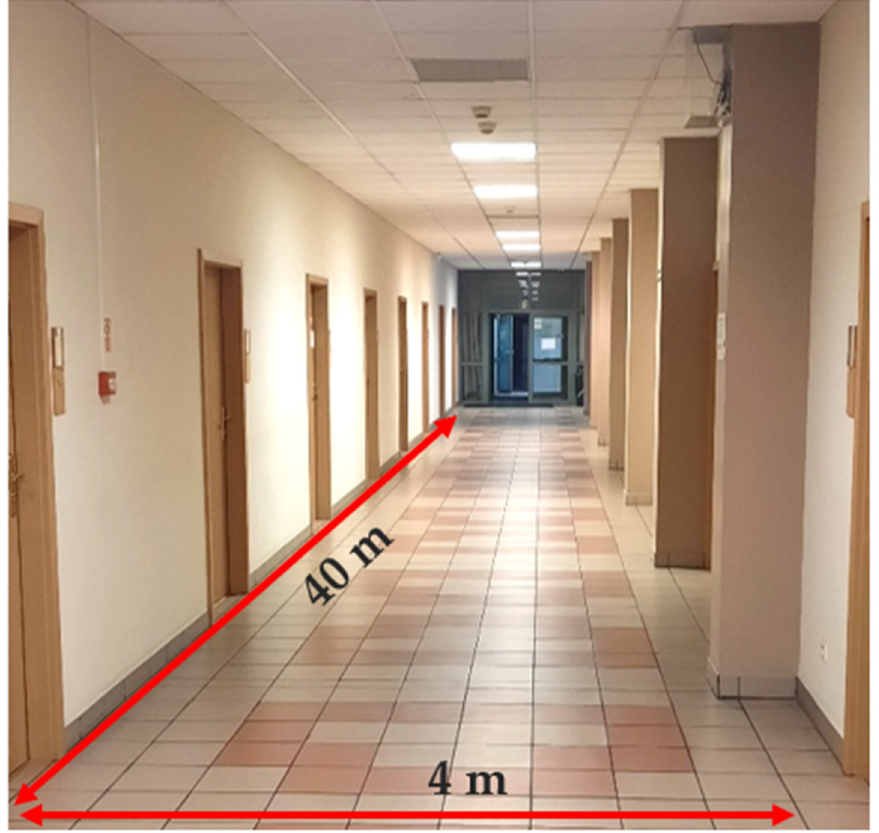
Figure 5. Photograph of scenario 1 (S1). Corridor of Institute of Electronics, Lodz University of Tech- nology.